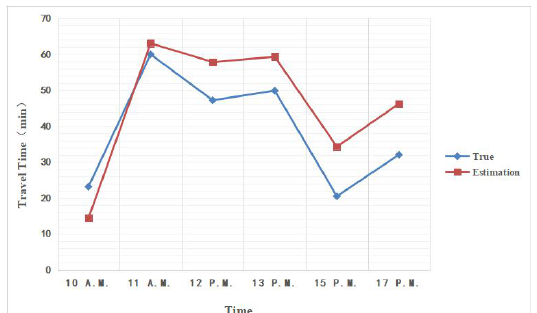
Figure 16. Travel time estimation of taxi ID 8662 on Friday